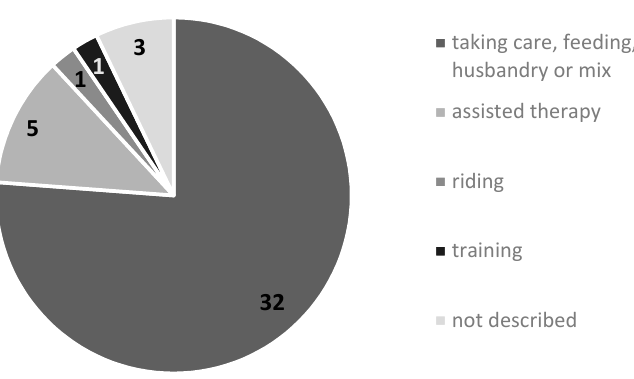
Figure 5. Categories of human–animal interactions ( n = 42).